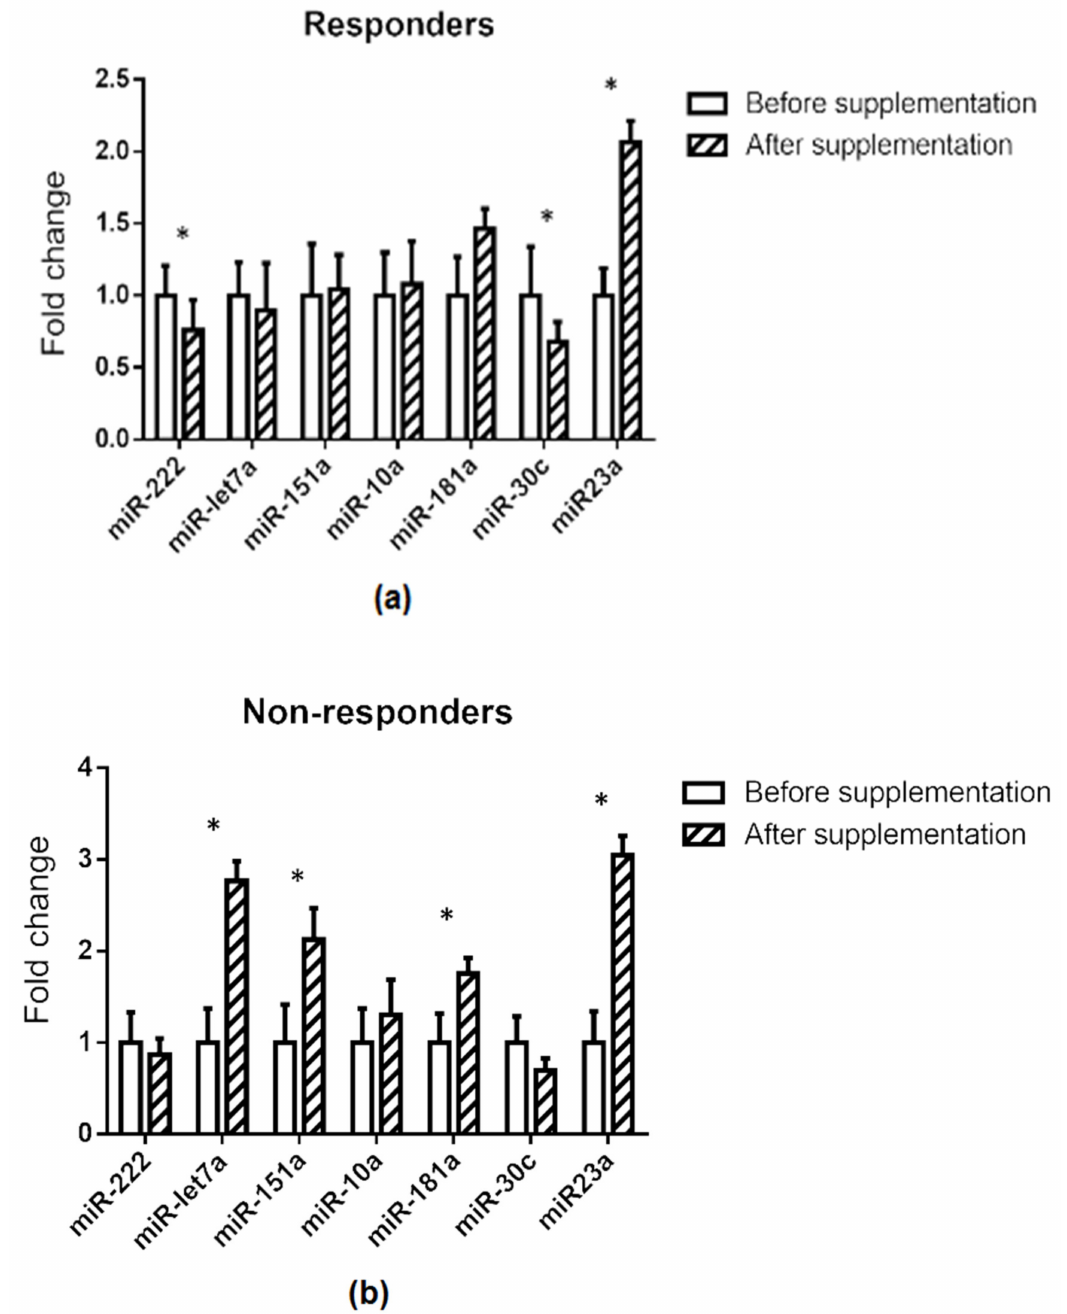
Figure 3. Relative miRNA expression before and after supplementation stratified in responders ( a ) and non-responders ( b ), based on fasting insulin reduction after supplementation. The 2 − ( ∆∆ Ct) method was used to calculate fold changes relative to the expression before supplementation. Values are presented as mean ± standard error of the mean. Comparisons were carried out using the paired Student’s t -test or Wilcoxon’s signed rank test when required. * p <